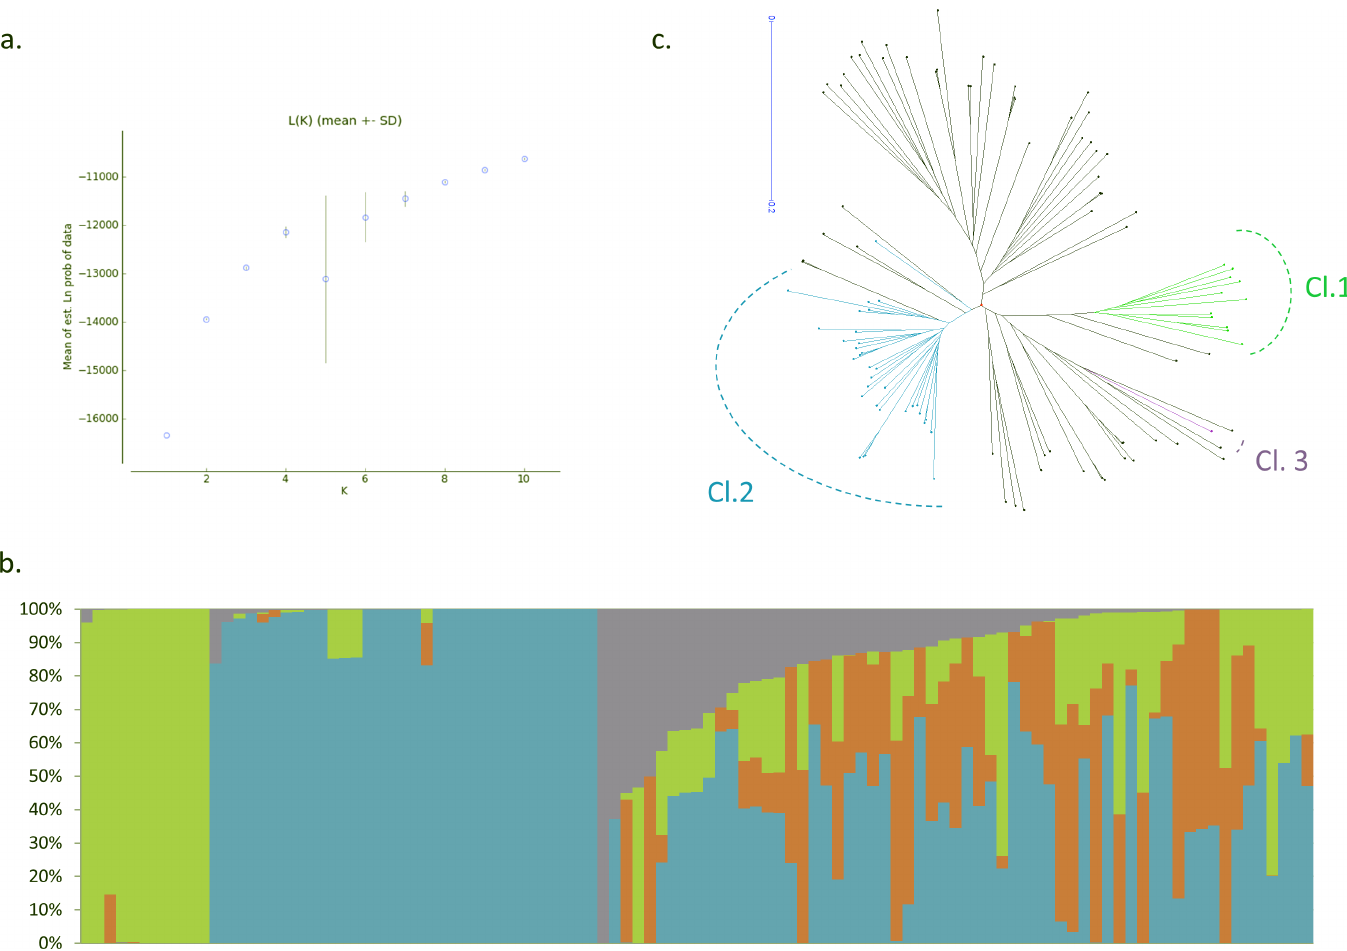
Fig 2. Genetic structure of the panel. STRUCTURE outputs: a. LnP(D) and its variance across 8 runs for each values of K, from 1 to 10, based on the genotypic data available for 498 DArT markers and b. Representation of the admixture pattern of the panel for K = 4 as calculated on the genotypic data obtained with the 5544 SNPs of the study, each bar corresponds to a genotype and colours correspond to the detected genetic clusters. c. NJ tree conducted on a Simple Matching dissimilarity matrix. Coloured branches correspond to unadmixed accessions (Q > 0.8) and black branches to admixed accessions (Q < 0.8) at K =